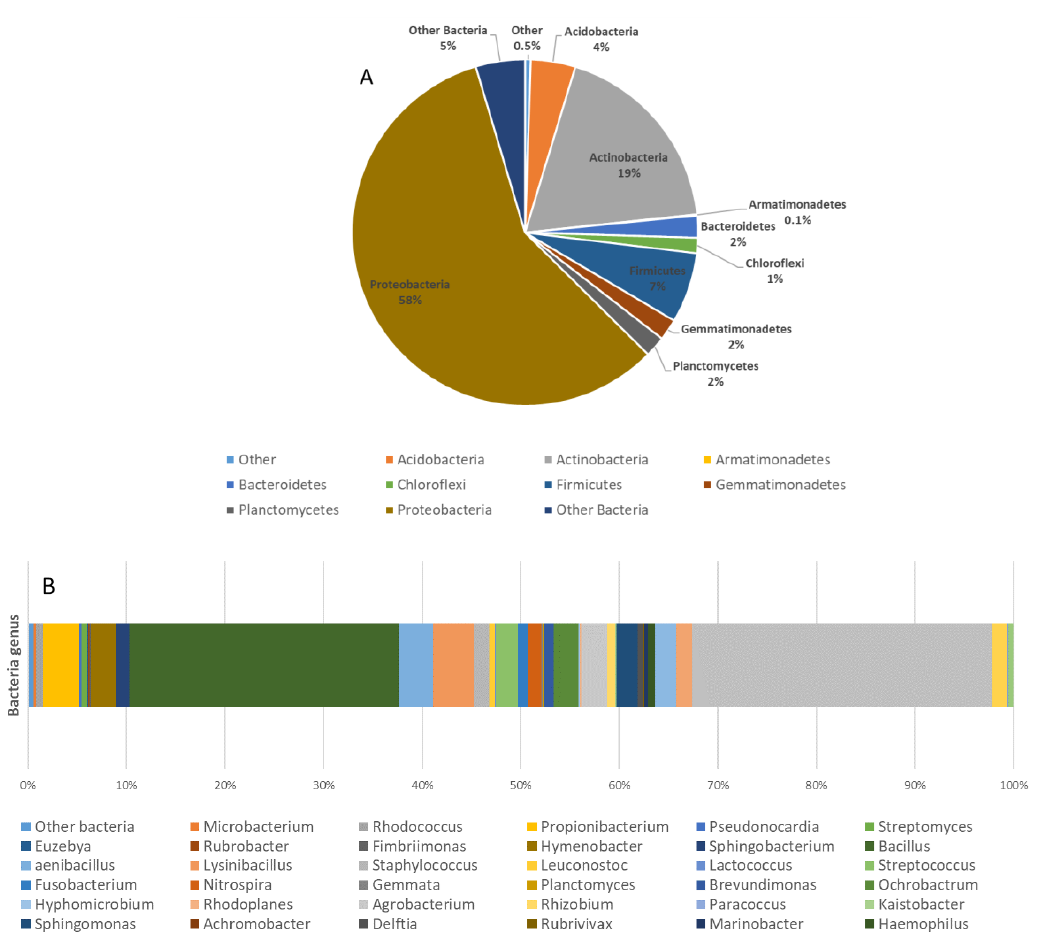
Figure 3. NGS evaluation of the microbial diversity of Escoural Cave. Bacterial phylum ( A ) and Genus ( B ) biodiversity.